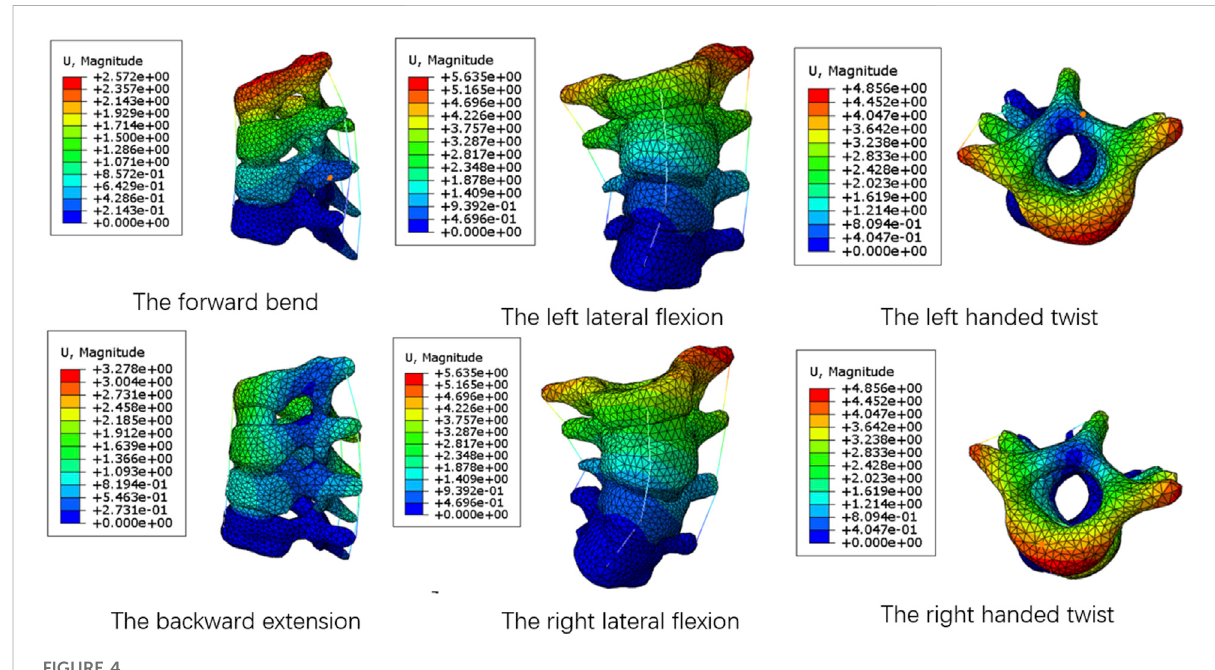
FIGURE 4 The displacement nephograms of T1 – T4 segments under six motion states.